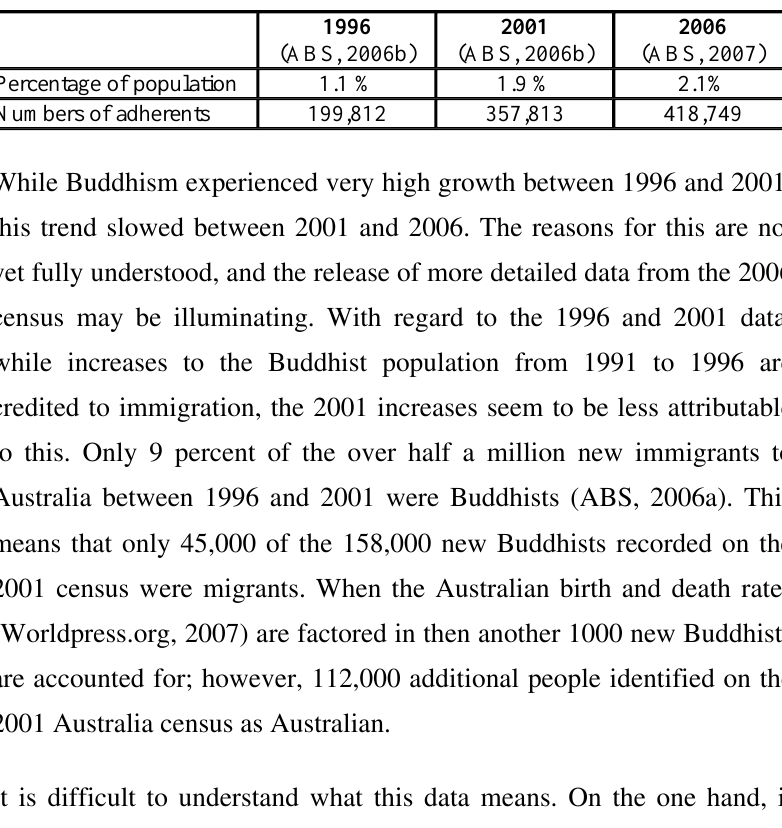
Table 1: Demographics of Australian Buddhists in 1996, 2001 and